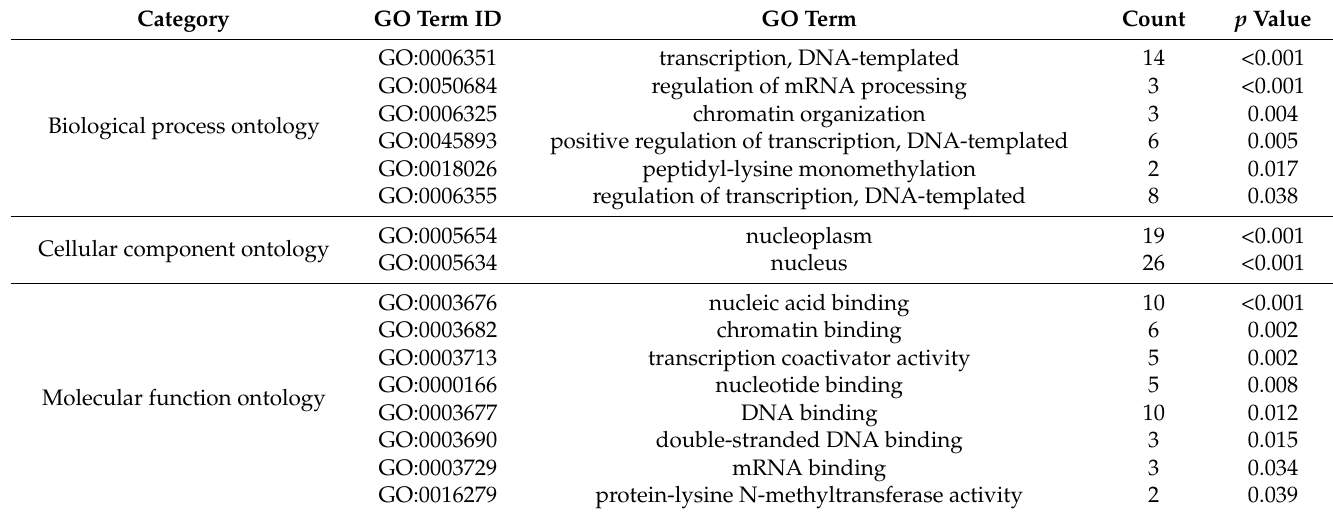
Table 4. Enriched Gene Ontology (GO) terms of the up-regulated genes in parathyroid adenoma. Category